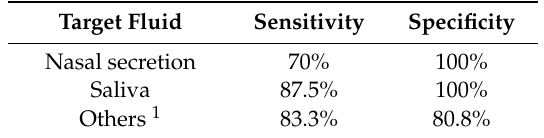
Figure 2. Proposed flowchart for discriminating among nasal secretions, saliva and other body fluids by RT-qPCR. (+), below the cutoff Cq values and determined as positive; (-), above the cutoff Cq values and determined as negative. Table 4. Results of discrimination according to the proposed flowchart.